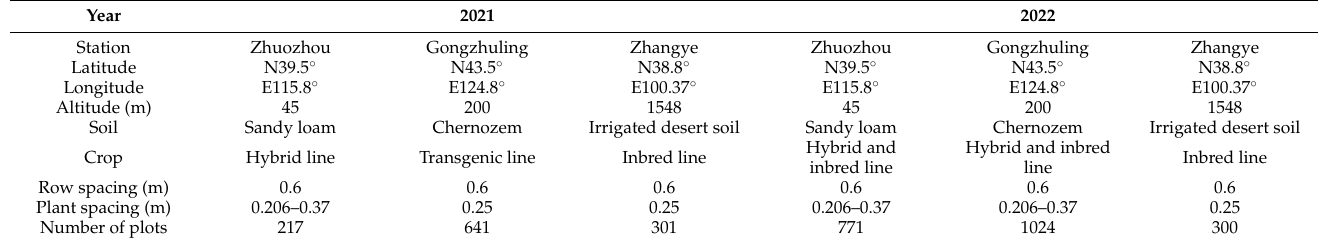
Table 1. Location and crop planting settings in Zhuozhou, Gongzhuling, and Zhangye during